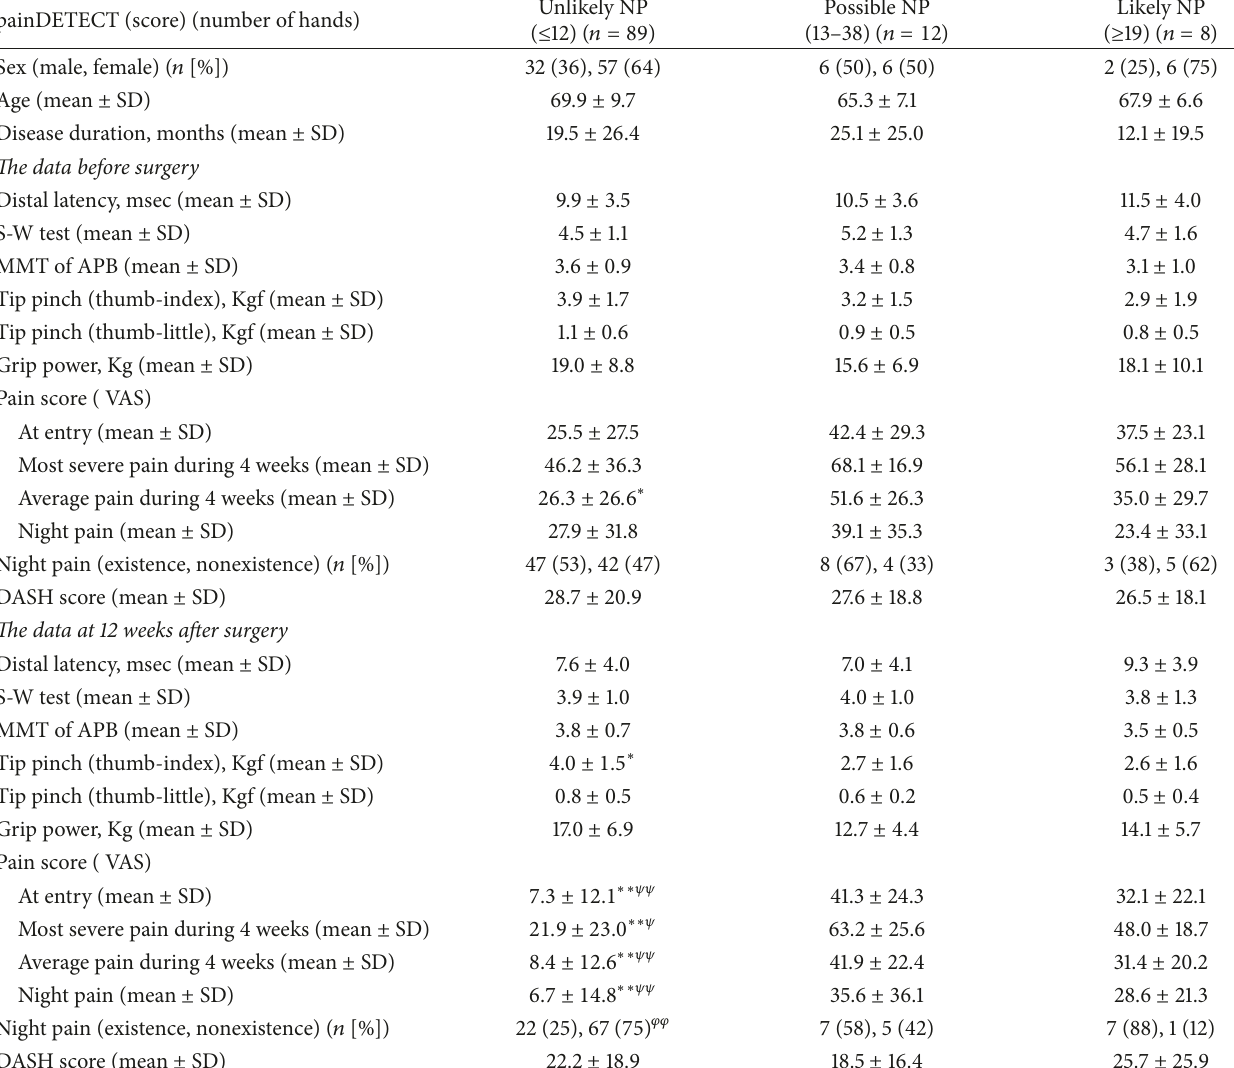
Table 5: The relationship between the painDETECT scores at 12 weeks after surgery and clinical characteristics. painDETECT (score) (number of